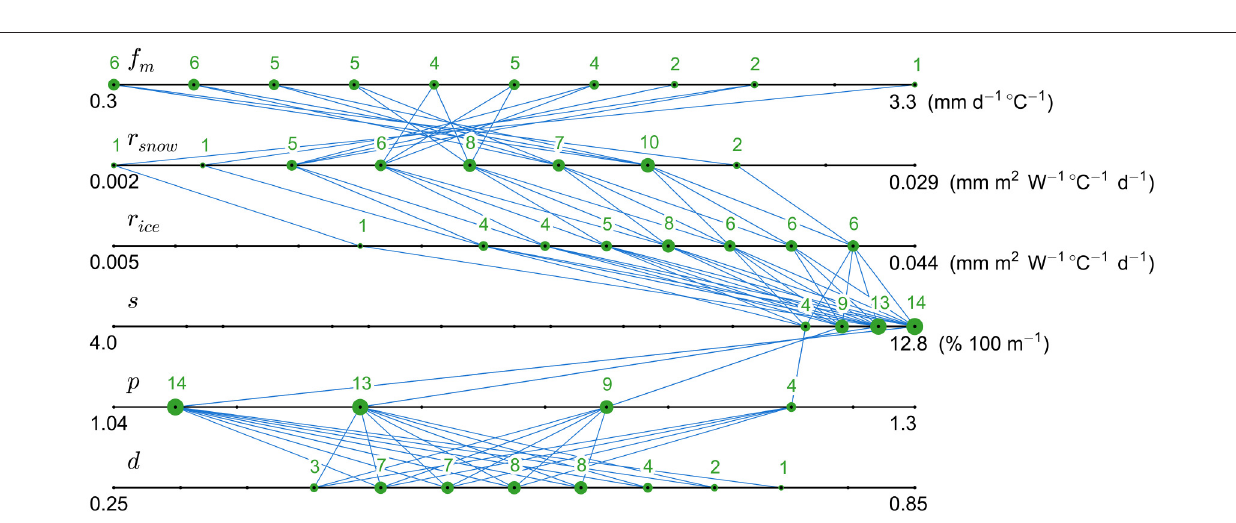
Frontiers in Earth Science |